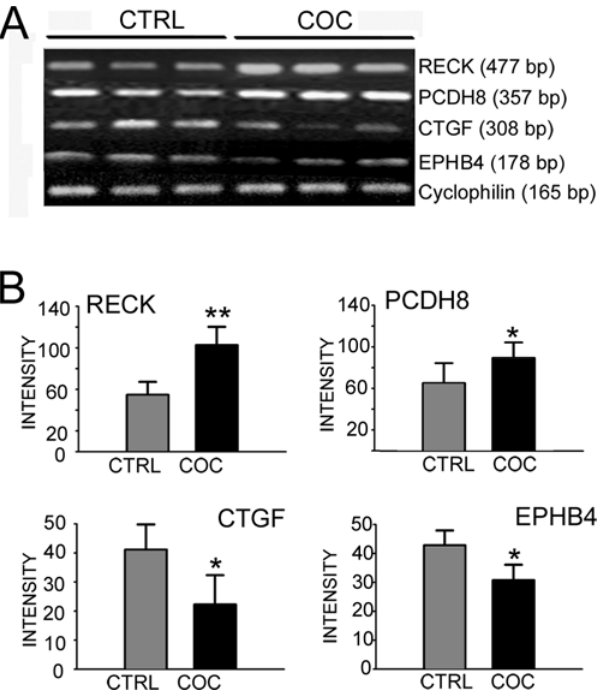
Figure 4. Western blot analysis of RECK, CTGF, and EphB4 protein expression in human postmortem hippocampus. A, Representative immunoblots with antibodies against human RECK, CTGF, and EPHB4 demonstrate elevated RECK and decreased CTGF, EPHB4 immunopo- sitive bands in the human hippocampus from cocaine overdose subjects as compared with age-matched, drug-free control subjects (n=8, respectively). B, Quantitation of protein expression. Optical density measurements are shown as percent control (y-axis). Data are means 6 SEM. ** p= 0.01 (one-tailed t-test), * p =0.05 (one-tailed t-test). doi:10.1371/journal.pone.0001187.g004 a reproducible reduction in MMP9, but no change in MMP2 in cocaine abusers. In keeping with the immunoblot evidence of a decrease in total protein, gelatin zymography demonstrates that cocaine exposure downregulates active MMP9 in human hippo-